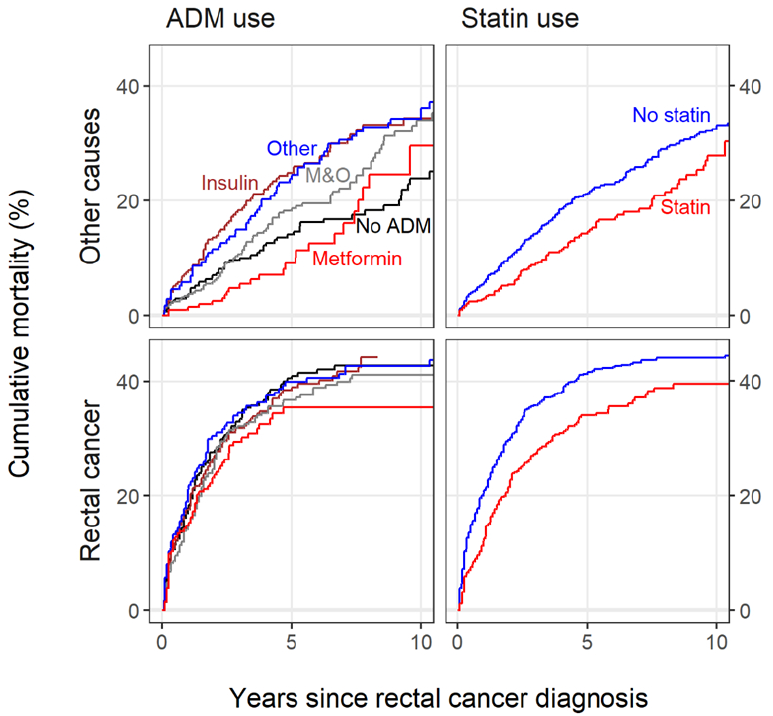
Figure 2. Cumulative mortality from rectal cancer and from other causes in the different pre-diagnostic medication groups. Antidiabetic medication (ADM): Red = metformin, blue = other oral ADM, brown = insulin, gray = metformin and other oral ADM, and black = no history of regular ADM use. Statin: Blue = non-users; red = users.